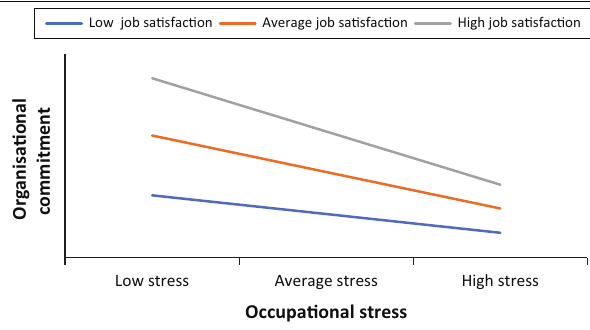
Low stress Average stress High Occupa(cid:26)onal stress FIGURE 3: Testing the interaction effect of job satisfaction on the relationship between occupational stress and organisational commitment.